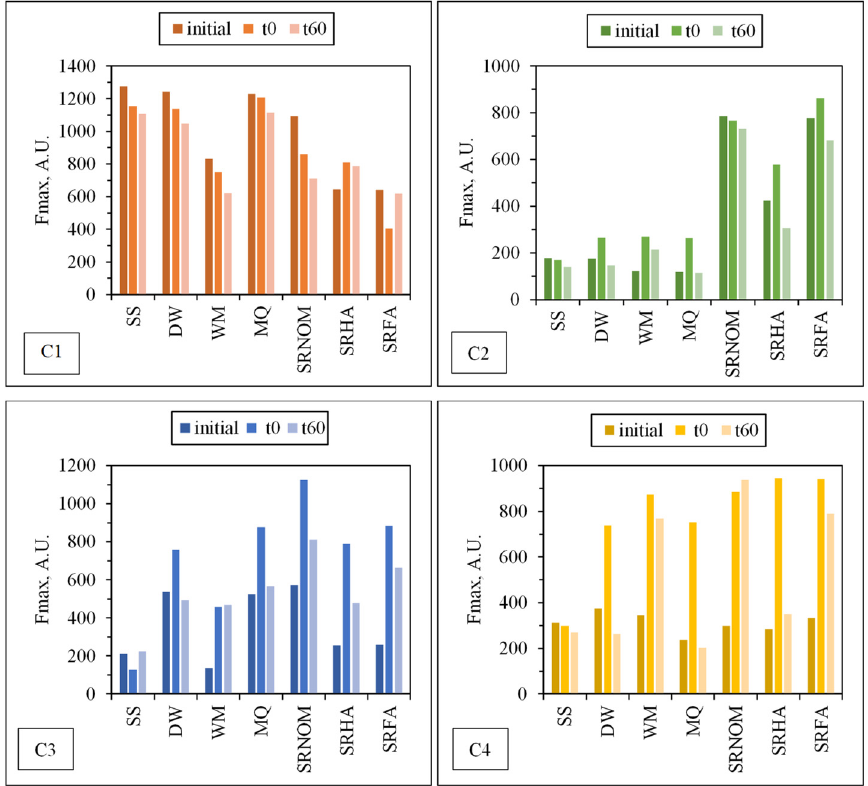
Figure 9. Changes in Fmax values of individual PARAFAC components prior to and following solar photocatalysis under all experimental conditions.